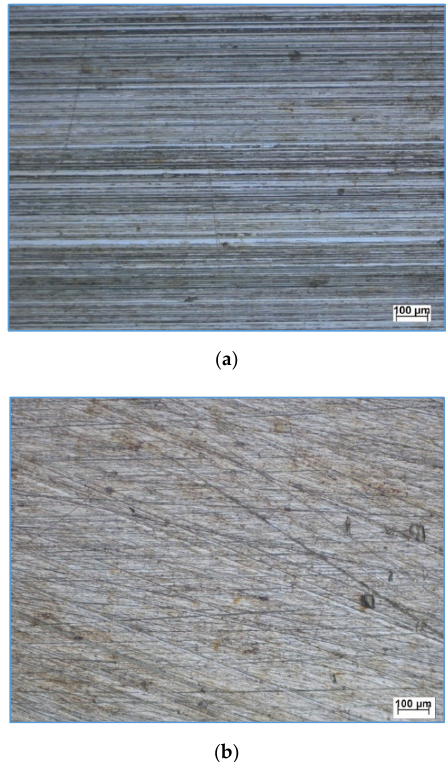
Figure 4. Top surface microscopy for the ground surface for ( a ) 180 grit and ( b ) 400 grit. Materials 2020 , 13 , x FOR PEER REVIEW